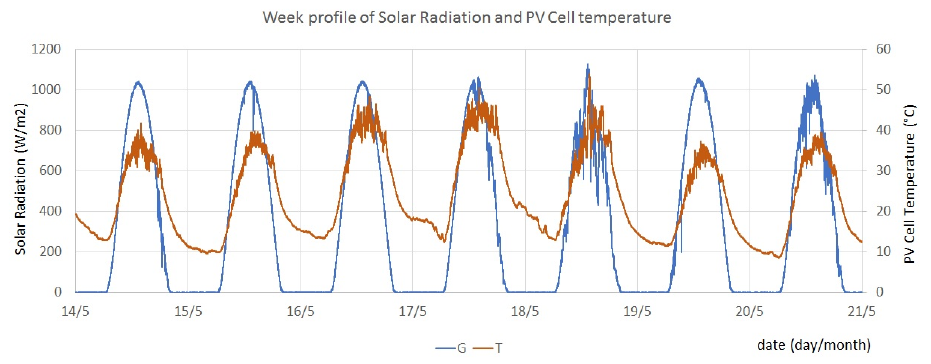
Figure 9. Week profile of Solar Radiation (PV plane) and PV Cell Temperature.